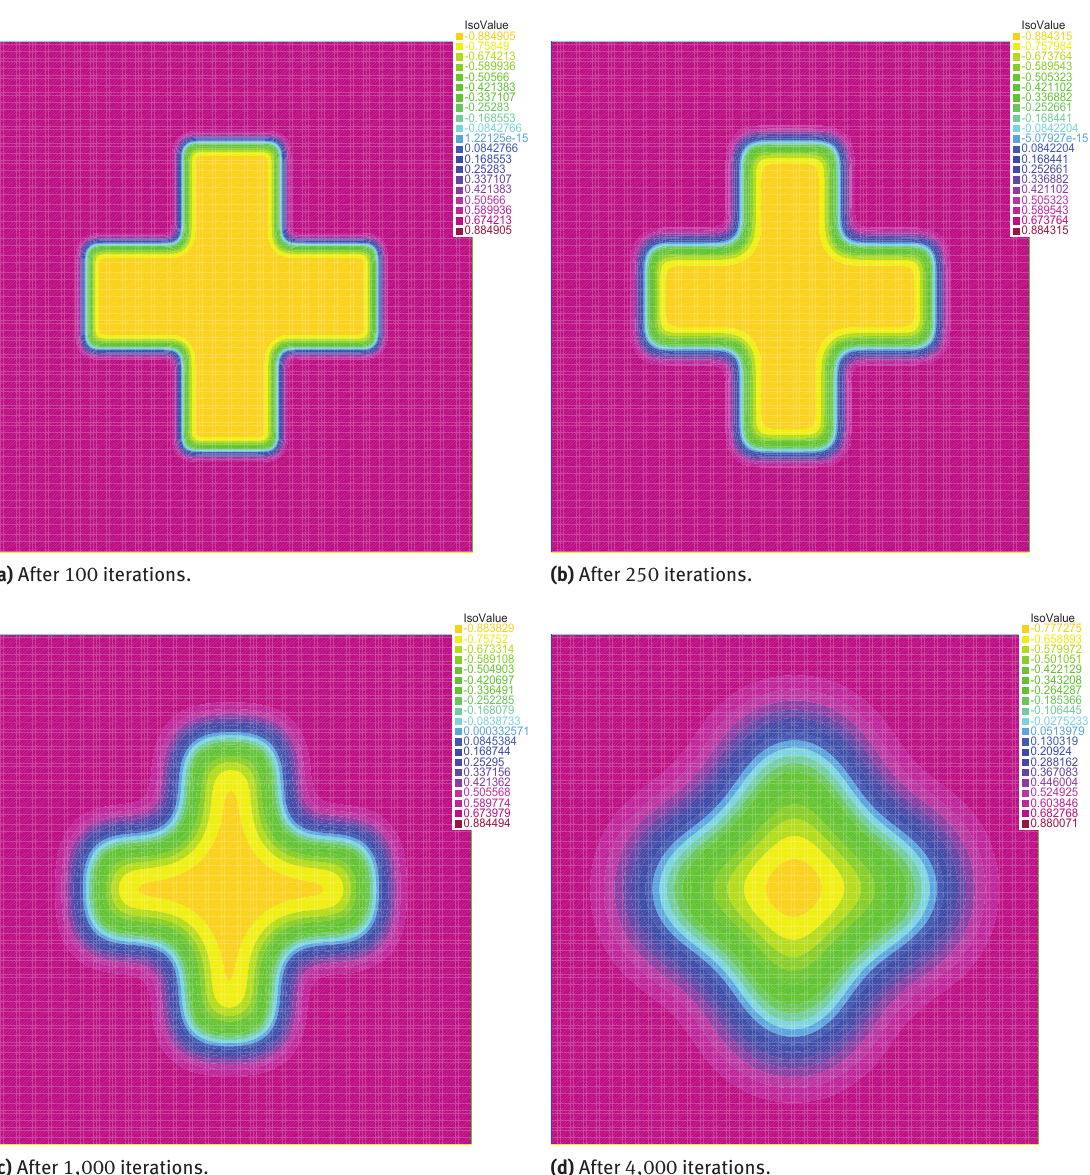
Figure 4: Results for k = 1, dt = 10 − 6